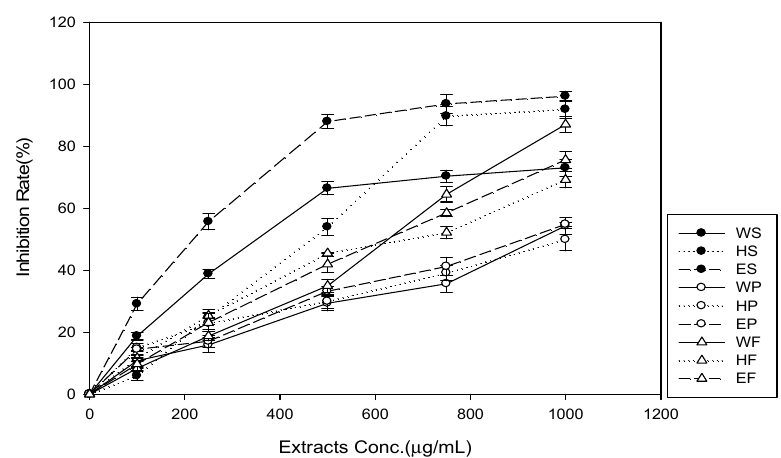
Figure 1. The antioxidant activity of crude extracts of Hylocereus polyrhizus parts, as measured by 2-2-diphenyl-1-picrylhydrazyl (DPPH) radical scavenging assay. WS, distilled water extract of stem; WP, distilled water extract of peel; WF, distilled water extract of flower; HS, 50% aqueous ethanol extract of stem; HP, 50% aqueous ethanol extract of peel; HF, 50% aqueous ethanol extract of flower; ES, 95% aqueous ethanol extract of stem; EP, 95% aqueous ethanol extract of peel; and, EF, 95% aqueous ethanol extract of flower.